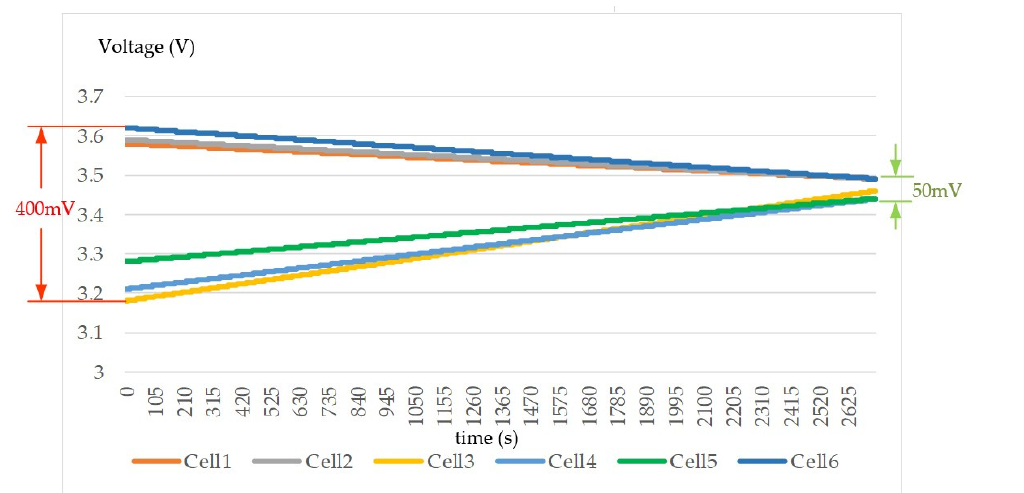
Figure 13. Measured results of each cell’s voltage using implemented bidirectional control strategy ( a ) actual hardware measurements ( b ) processed results.